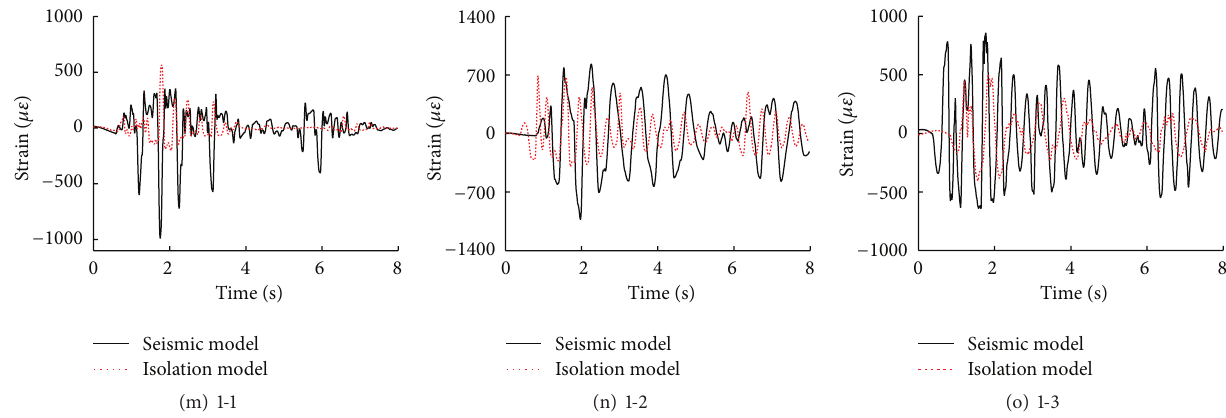
Figure 10: Comparison of strain time history curves. Note: 0.25-1 shows the strain time history curve at the bottom of pier #1 when the input peak acceleration of seismic wave was 0.25 g PGA and similar to other